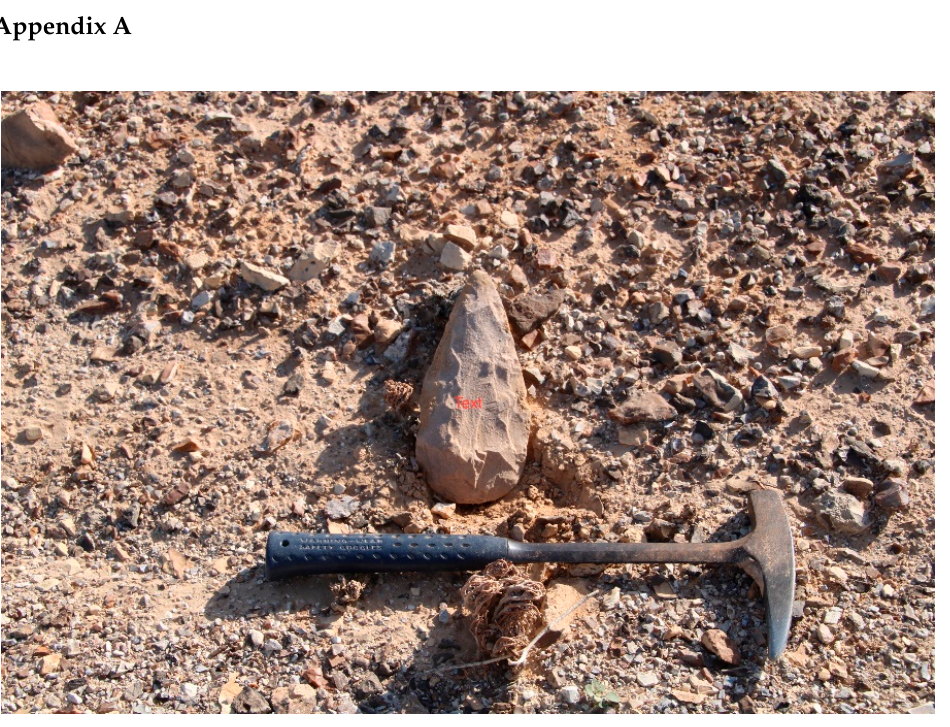
Figure A2. Alluvial pebbles and gravels laid down by the Nile in northern Sudan 20,000 years ago. The bivalve shells are a freshwater Nile mussel, most probably Mutela sp.